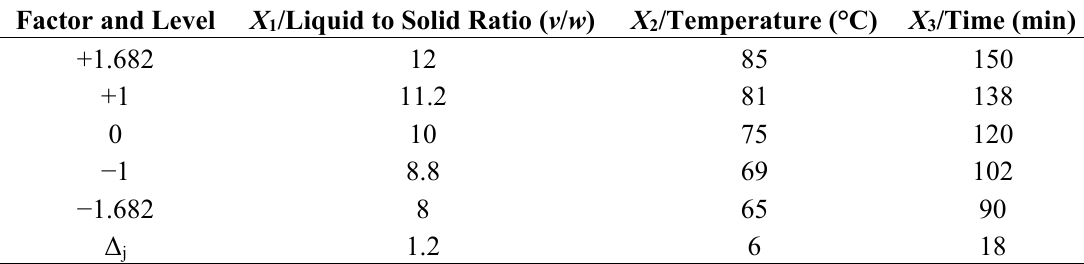
Table 4. Experimental coding for factor and